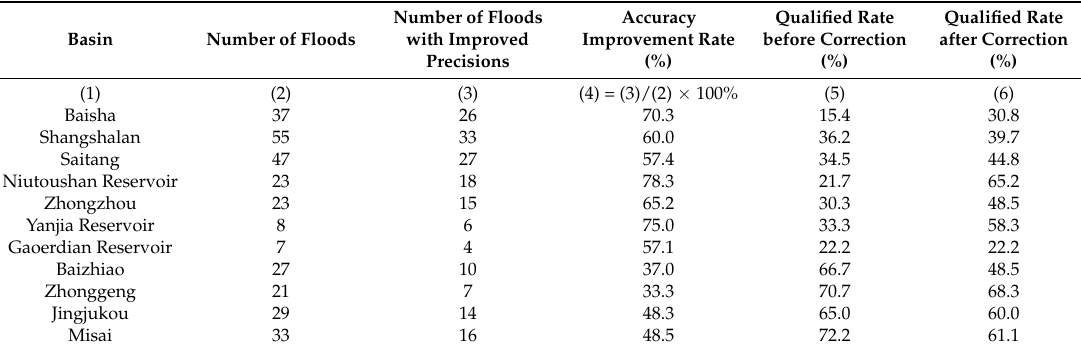
Table 10. Correction effect of flood forecasting of each basin.